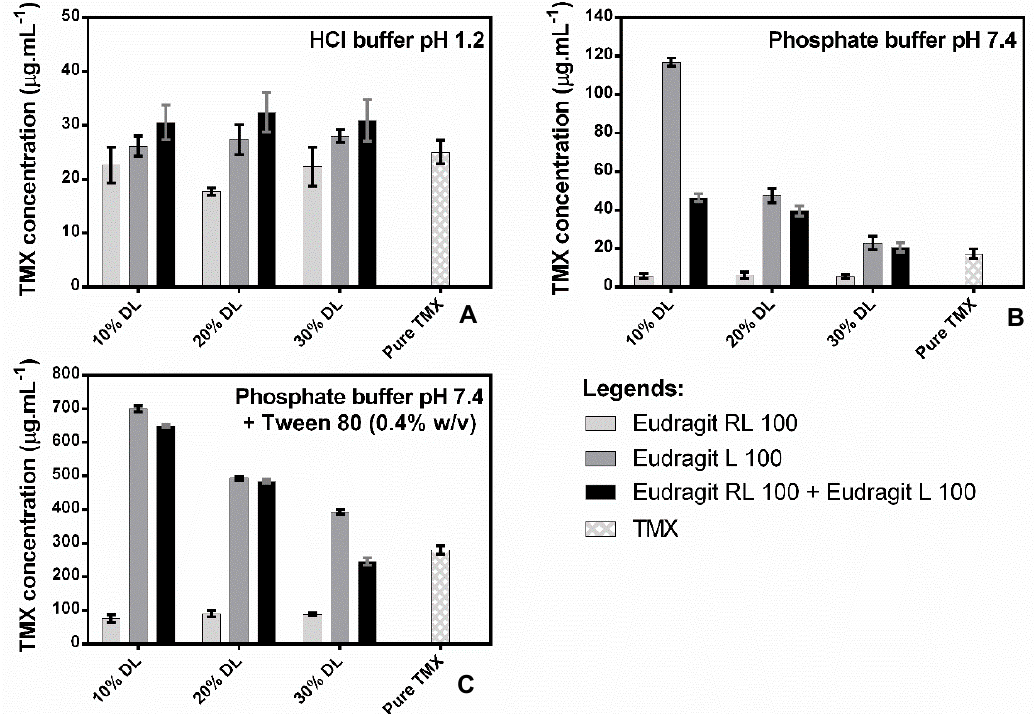
Figure 5. Equilibrium solubility of crystalline TMX in the absence or presence of presuspended